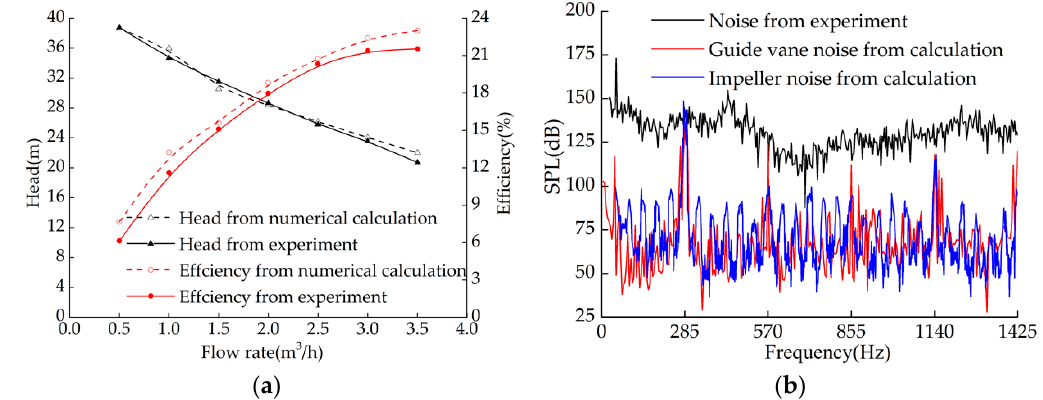
Figure 5. Comparison of performances between the experiment and numerical calculation. ( a ) Comparison of hydraulic performance; ( b ) comparison of frequency response curves of the sound pressure level.